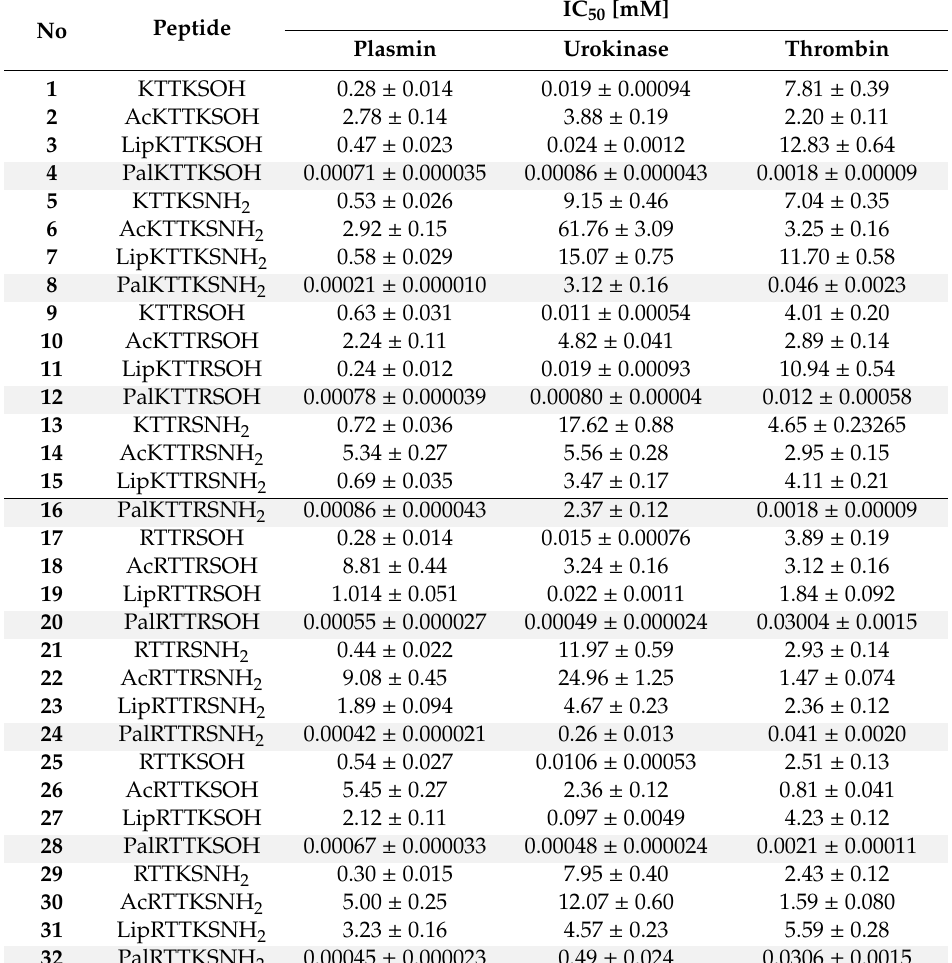
Table 1. Influence of the tested compounds on amidolytic activity of plasmin, urokinase, and thrombin in the form of IC 50 [mM] (peptides most active as enzyme inhibitors are marked grey).